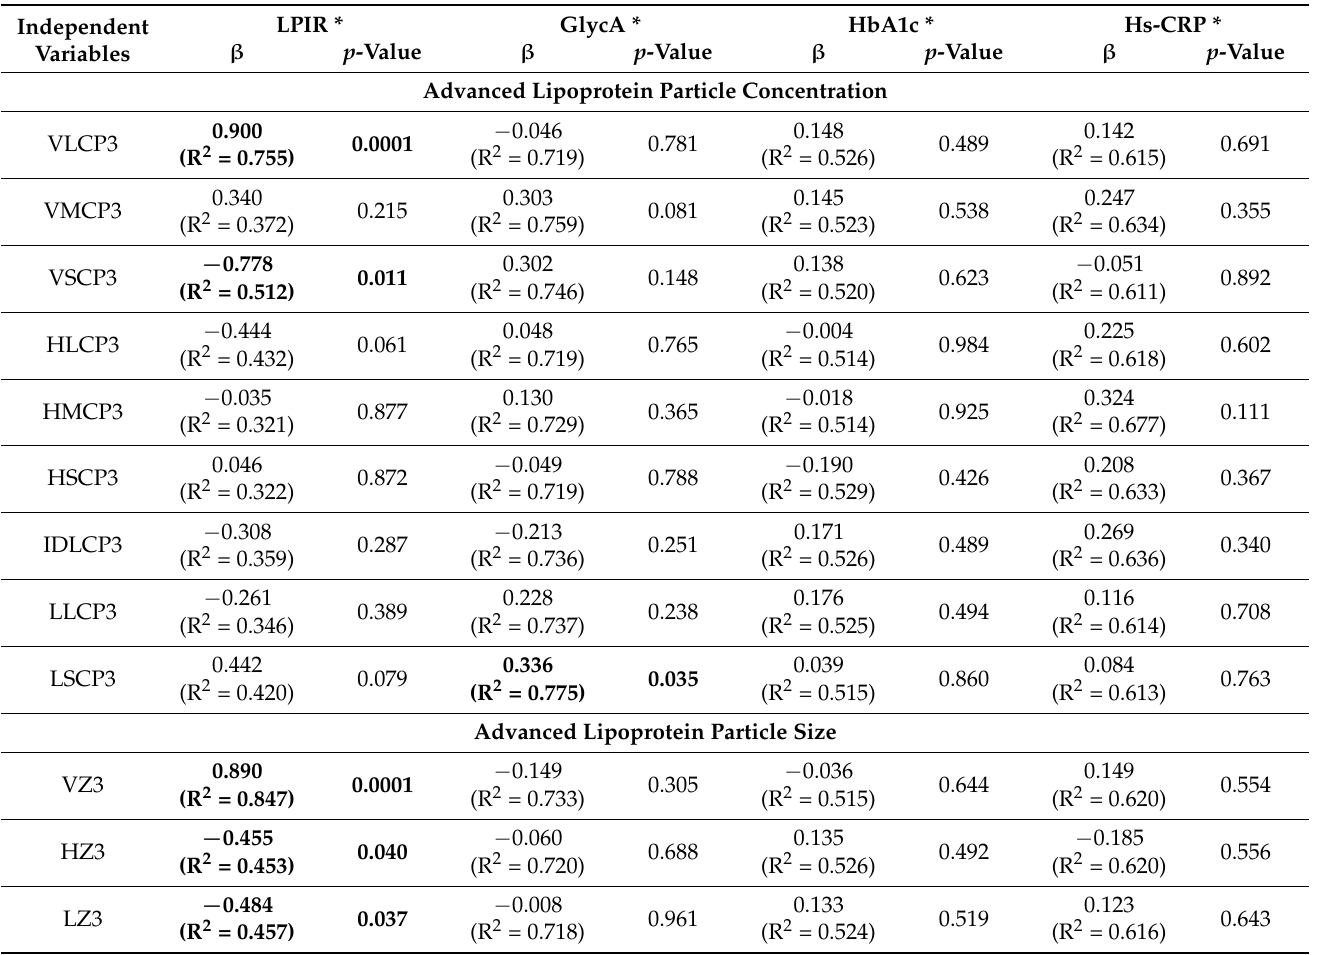
Table 6. Multiple linear regression analysis of the association of lipoprotein subpopulations with glycemic and inflammation parameters in T2DM